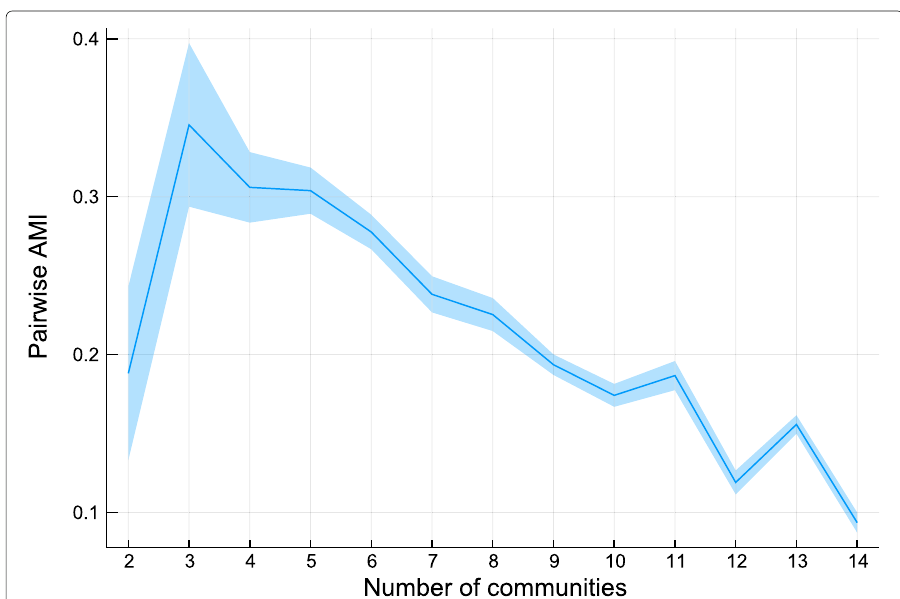
Fig. 10 Choosing the number of communities: Cargo. Left: the mean pairwise adjusted mutual information of the community-node membership across repeated decompositions. 1 is a perfectly stable assignment to communities; 0 is perfectly random. The shaded area corresponds to twice the standard error of the mean. Right: the mean normalised residual sum of squares error for repeated decompositions on the Cargo network against the number of components. The shaded area corresponds to twice the standard error of the mean above and below the